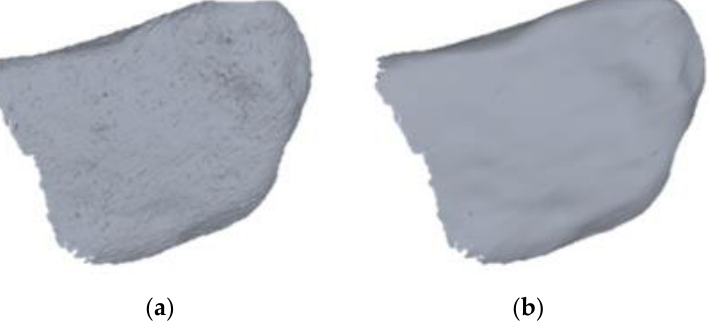
Figure 7. Comparison diagram of coarse aggregate before and after smoothing. ( a ) Pre-processing model; ( b ) Processed model.